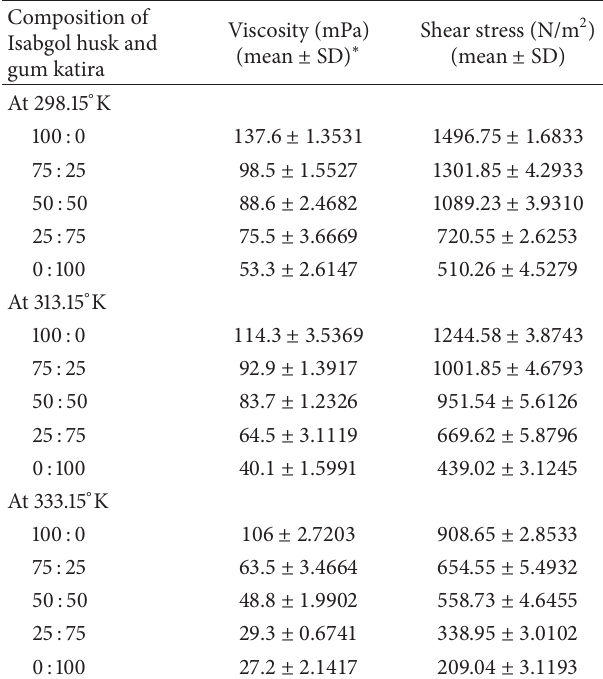
Table 1: Viscosity and shear stress of Isabgol husk, gum katira, and their blends having 1 :1 mass% of Isabgol husk and gum katira